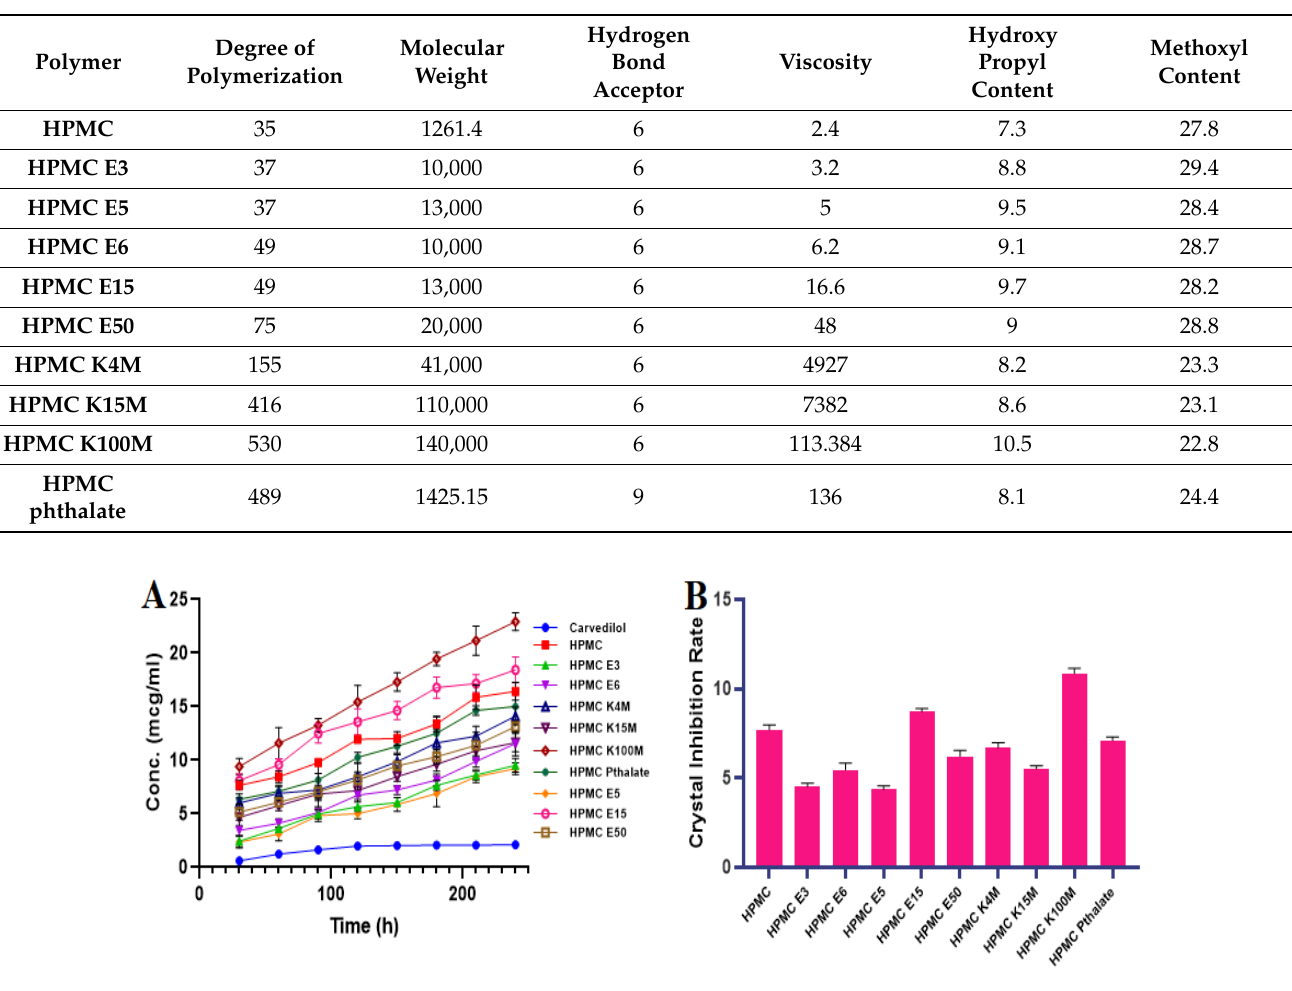
Table 1. Properties of the different grades of polymers.